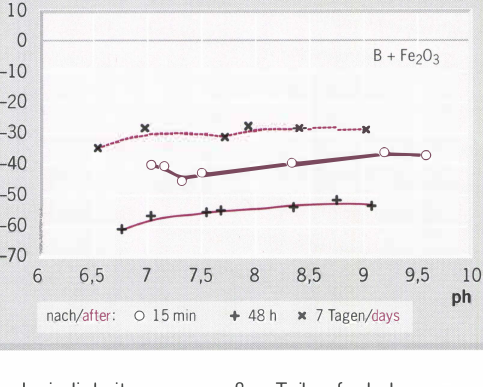
Fig. 4: Flow and viscosity curves of binder B with and without